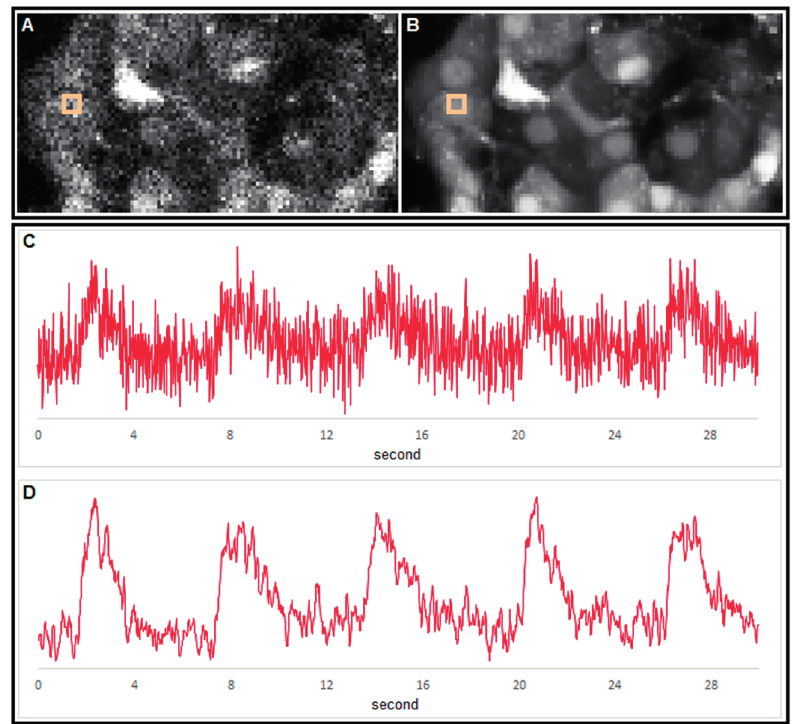
Figure 5. Extraction of spatial and temporal information from [Ca 2+ ] i time series using our analytical approach. ( A ) A single image from a [Ca 2+ ] i time series. Cells were loaded with OGB-1 AM. The resolution was 256 × 64 pixels @ 50 Hz; ( B ) the average image reveals outlines of cells with cell nuclei stained more intensely than the cytoplasm. The image was averaged over 18,000 frames; ( C ) [Ca 2+ ] i signal obtained from 3 × 3 pixels indicated with rectangles in panels A and B; and ( D ) the same signal after denoising. Noise was removed using a Gauss convolution kernel 3 × 3 and a standard deviation of 1 for the spatial domain and moving average filter with a window of length 7 with low cut 1 and high cut 1. The signal has not been amplified.